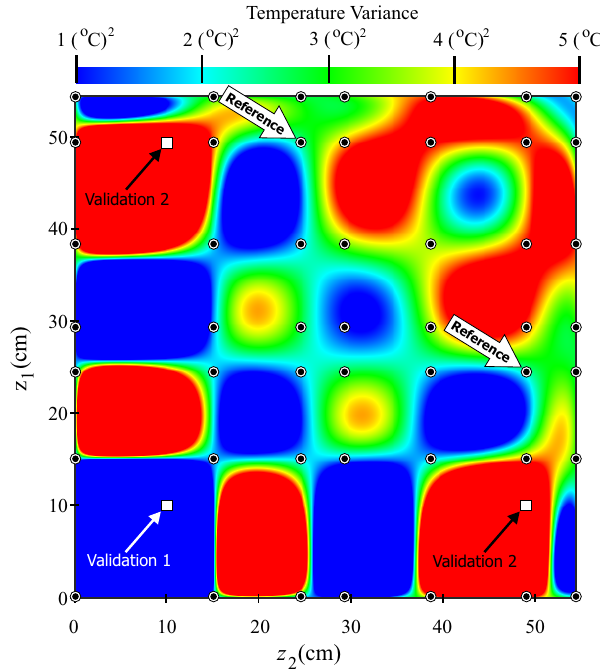
Figure 9. Temperature variance using Lagrange’s interpolation.